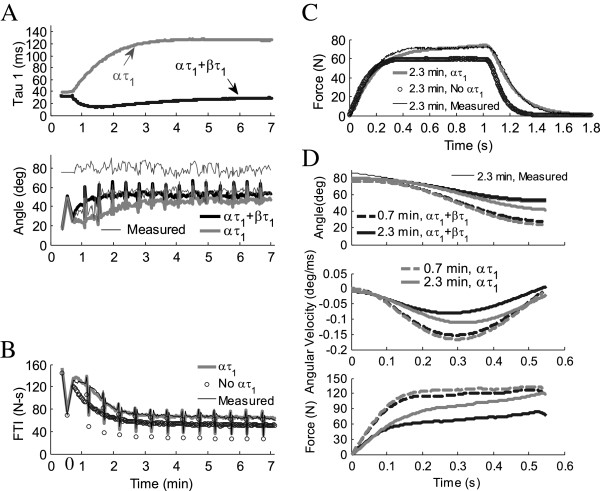
Effects of fatigue model parameters ατ1and βτ1on isometric and non-isometric contractions in one subject where βτ1was higher than average. (A) Addition of βτ1(dθ/dt) to ατ1 in Equation 8 brings force relaxation time constant, τ1, closer to pre-fatigue value (top), resulting in non-isometric predictions with a faster rate of fatigue (bottom). Thin solid black lines are measured values, just prior to (80°) and at end of extension. (B) For isometric contractions, removal of ατ1 in Equation 8 keeps τ1 constant at pre-fatigue value, resulting in isometric predictions with a faster rate of fatigue (FTI =force time integral). (C) A single isometric contraction shows that when ατ1 is included in isometric Equation 8, progressively slower twitch relaxation times increase the force of contraction. (D) Single non-isometric contractions show that addition of βτ1(dθ/dt) to Equation 8 partially negates the effect of ατ1. In A. and B. pairs of 50CFT and 12.5VFT testing trains were followed by 13x33CFT fatiguing trains. Contractions in (C) and (D) occurred at 0.7 min (dashed line) and 2.3 min (solid line). Non-isometric: 4.54 kg load, 250 μs pulse duration. Isometric: 600 μs pulse duration. Initial force-motion model parameters: A90 = 2.10 N/ms, Km = 3.52e-01, τ1 = 36.1 ms, τ2 = 52.1 ms, τc = 20 ms, R0 = 2, a = −4.49e-004 deg-2, b = 3.44e-02 deg-1, V1 = 3.71e-01 N/deg2, V2 = 2.29e-02 deg-1, L/I = 9.85 kg-1m-1, FM = 247.5 N. Fatigue model parameters: τfat = 99.4 s, αA = −4.03e-07 ms-2, αKm = −1.36e-08 ms-1N-1, ατ1 = 2.93e-05 N-1, βτ1 = 8.54e-04 ms deg-1N-1.